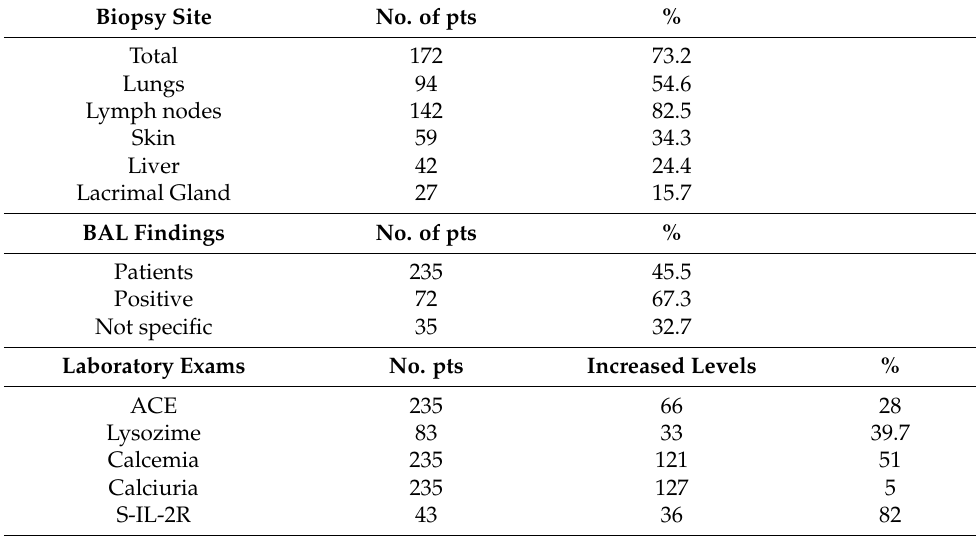
Table 5. Biopsy, BAL, and laboratory findings.